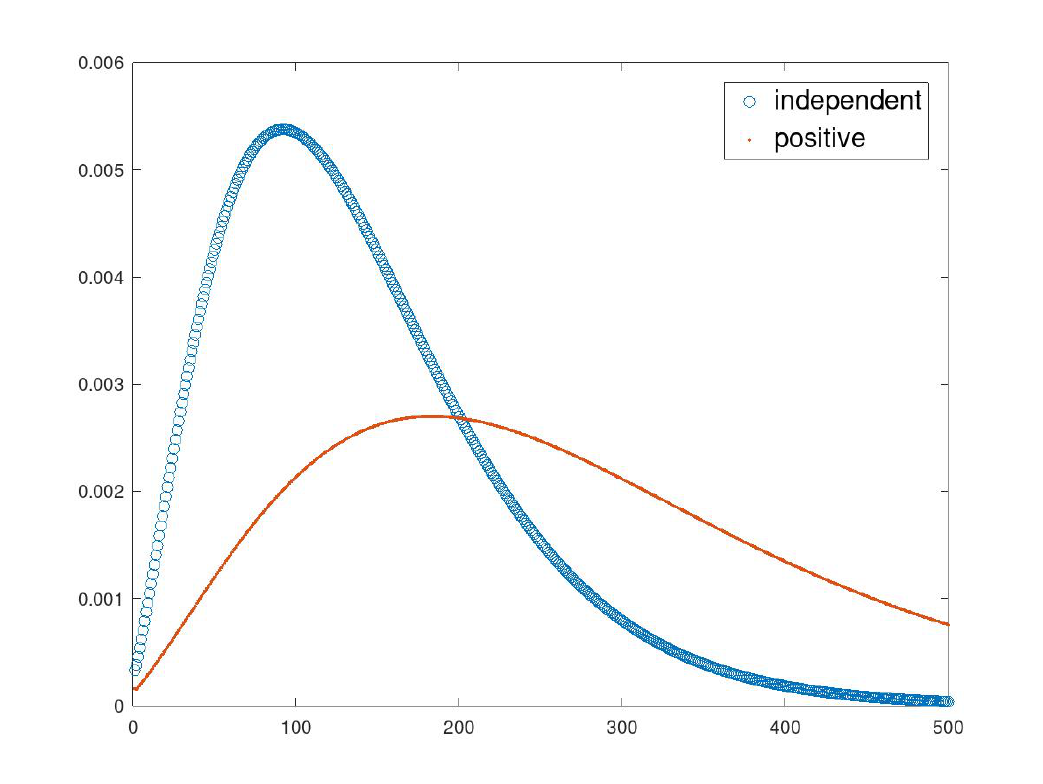
Figure 5. Probability mass functions of the N 0 -valued portfolio loss ˆ S for different dependence structures for the two claim cause intensities Λ 1 and Λ 2 satisfying E [ Λ 1 ] = E [ Λ 2 ] = 1.05. We take V = R . The claim size equals 1 in all cases, i.e., X s